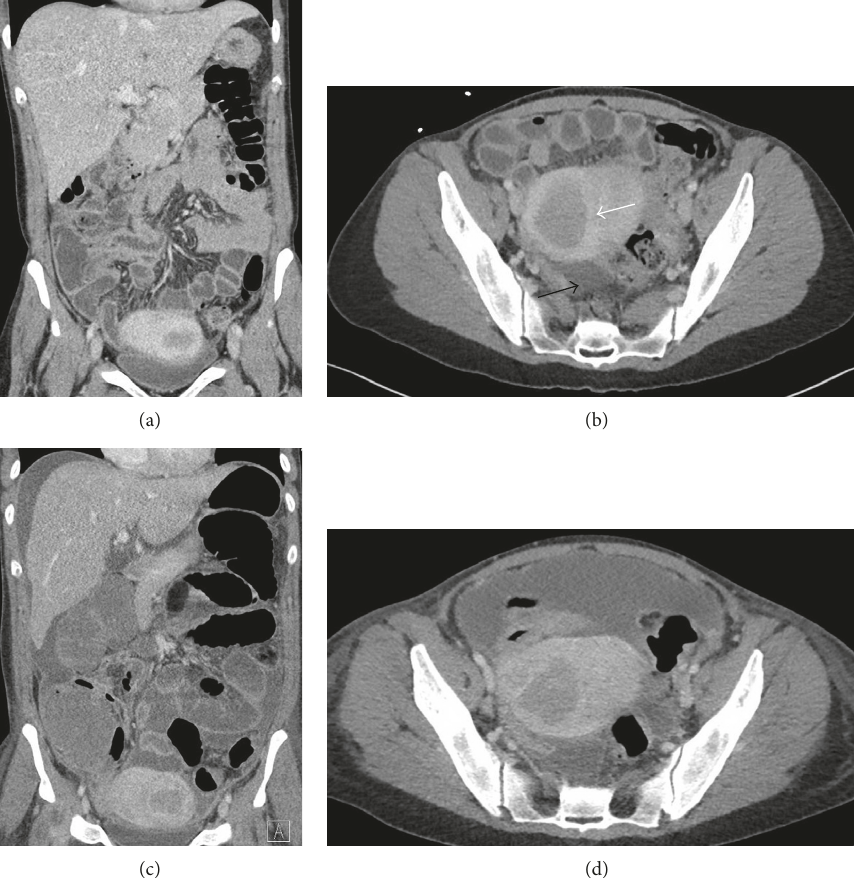
Figure 1: Initial CTscan upon presentation (a, b) with uterine fibroids (white arrow) and minimal free fluid (black arrow). CTscan four days after admission with worsening ascites (c,